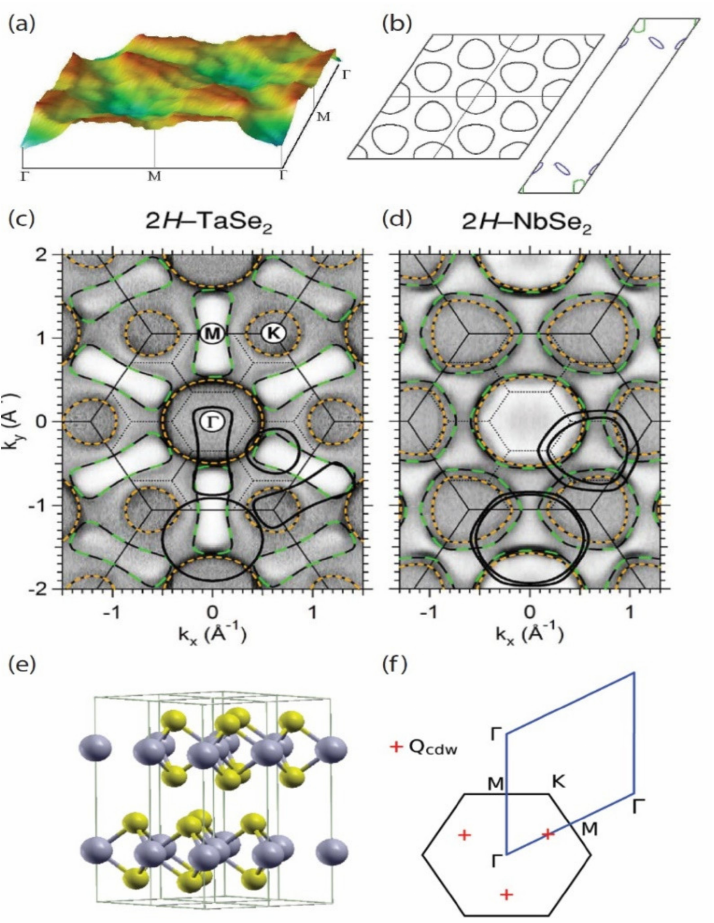
Figure 1. ( a ) Real part of the bare static electronic susceptibility (in arbitrary units) with constant matrix elements. This was calculated by using the band structure of monolayer NbSe 2 . ( b ) The